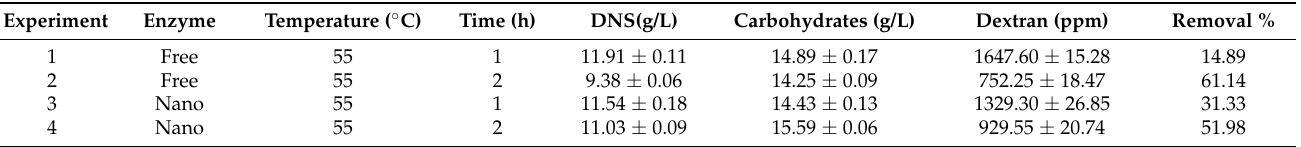
Table 6. Residual dextran, residual DNS, and residual carbohydrate concentration after enzymatic degradation treatment with free enzyme and immobilized dextranase with Fe 3 O 4 NPs.